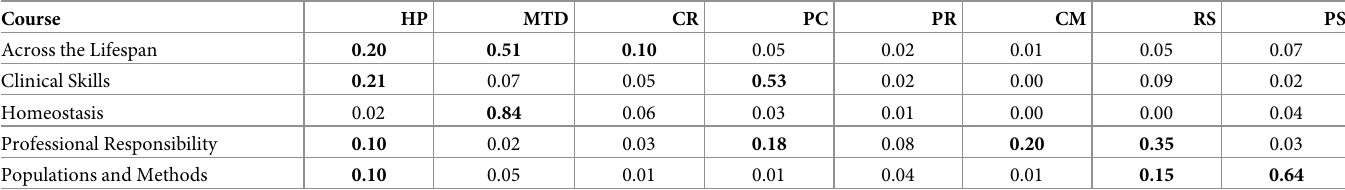
Table 3. Mapping course content to competencies.